Question: Provide a one-line summary of what is displayed.
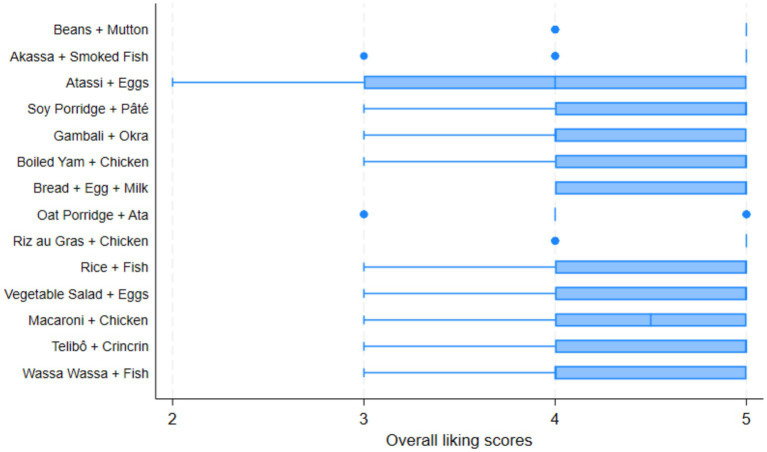
Answer: Distribution of overall liking scores across adapted recipes.